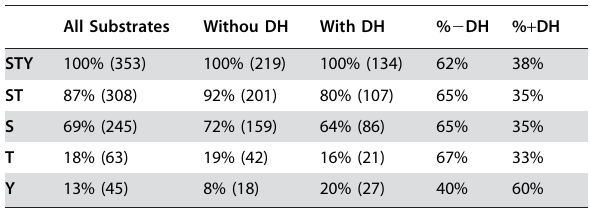
Table 2. Distribution of the other phospho acceptors, histidine (H) and aspartate (D) in monophospho motifs (containing only one S, T or Y). .. ... .... ... ... .... ... ... .... ... ... .... ... ... .... ... ... .... ... ... ....